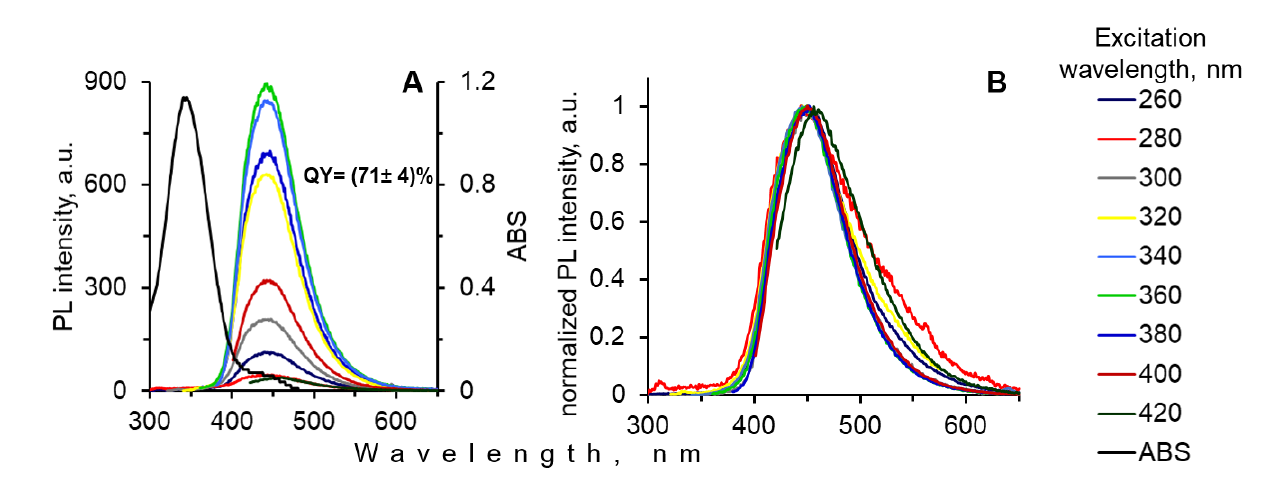
Figure 2. Absorbance and luminescence spectra ( A ), and normalized luminescence spectra ( B ) of IPCA fluorophore purified by